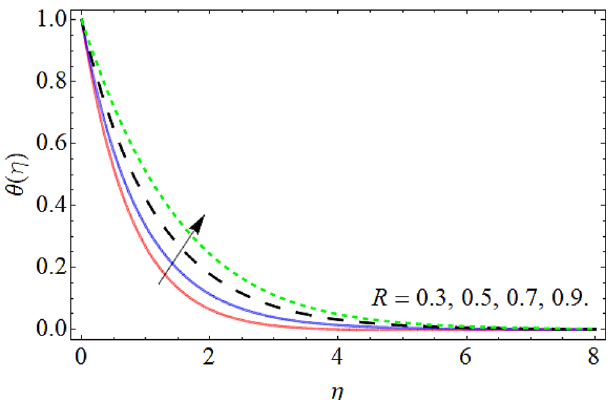
Figure 11. Energy profile versus the thermal radiation R .